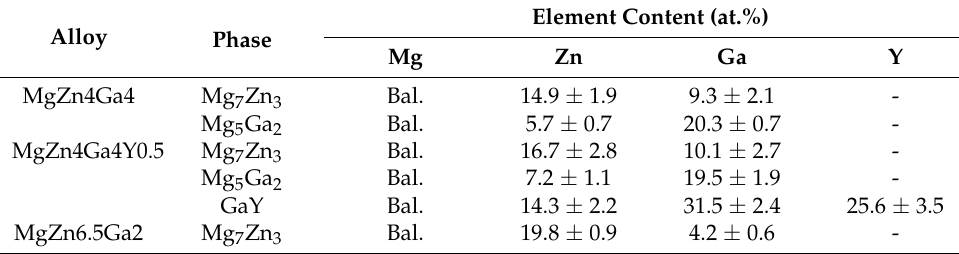
Table 2. EDS analysis results of the as-cast high-alloyed Mg − Zn − Ga